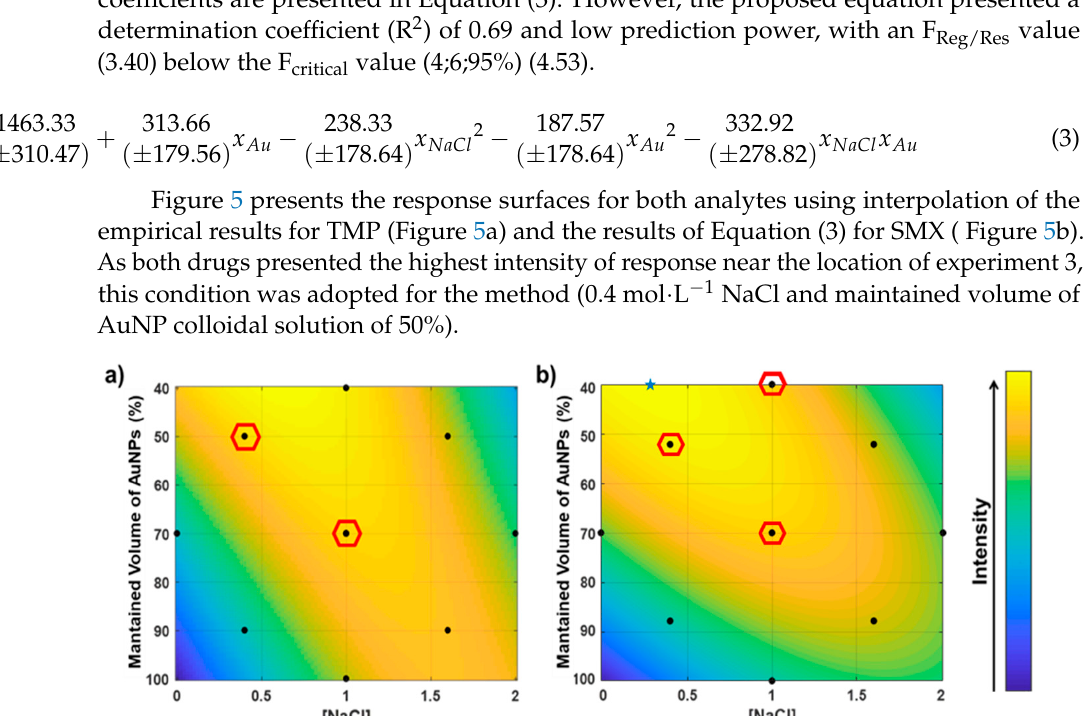
Figure 6. SERS spectra with pH variation for ( a ) SMX and ( b ) TMP. 3.3. SMX Quantification Calibration curves were prepared using the optimized experimental conditions. Standard solutions containing both drugs were eluted on the TLC plates using AcEt:MeOH (75:15 v/v) mobile phase. The AuNP colloidal solution was preconcentrated, discarding half the volume of the supernatant after centrifugation, and 2 μ L of 0.4 mol L − 1 NaCl was added to 100 μ L of concentrated AuNPs. Each standard solution was prepared and analyzed in three replicates. The performances of the MCR and ICA chemometric methods for signal resolution were compared through the quantification of analytes.